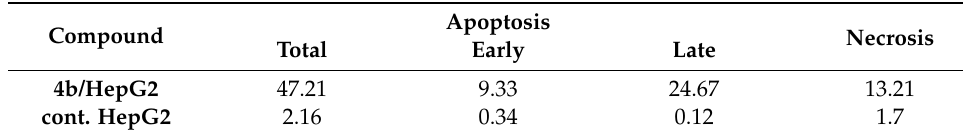
Table 4. Cell cycle analysis and apoptosis detection of hybrid 4b .